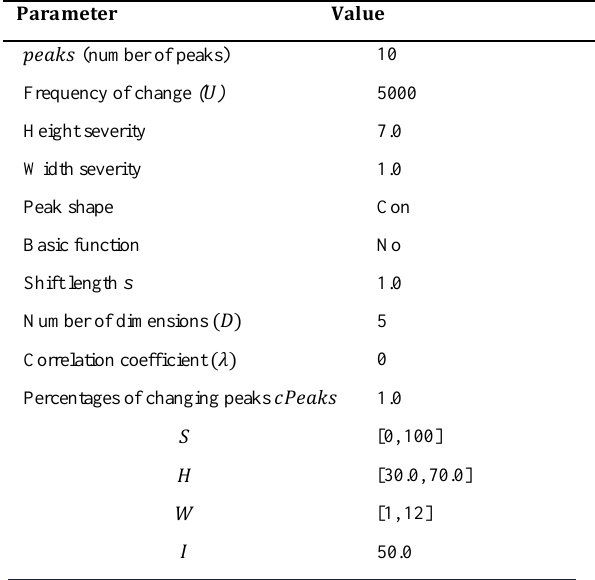
Table 1. Standard configuration parameters for MPB problem [22].